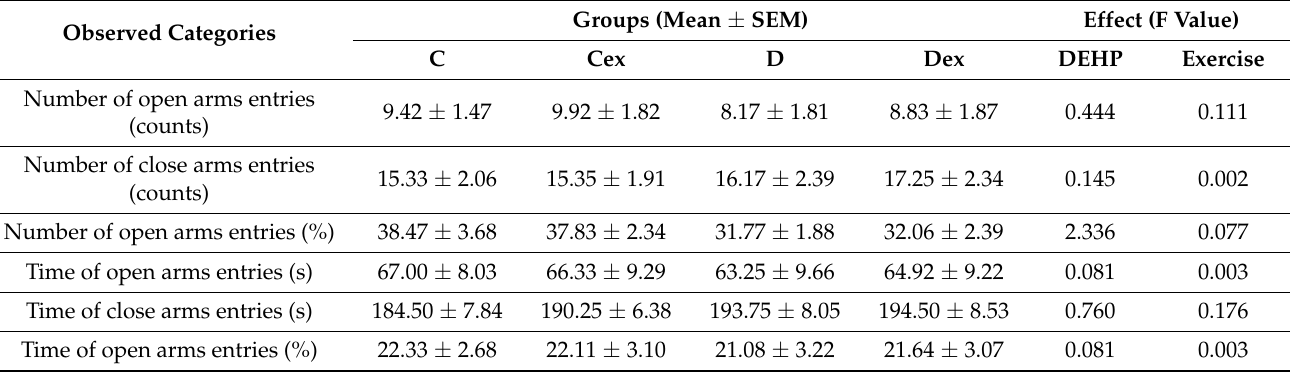
Table 1. Effects of prenatal DEHP exposure and childhood exercise on anxiety-like